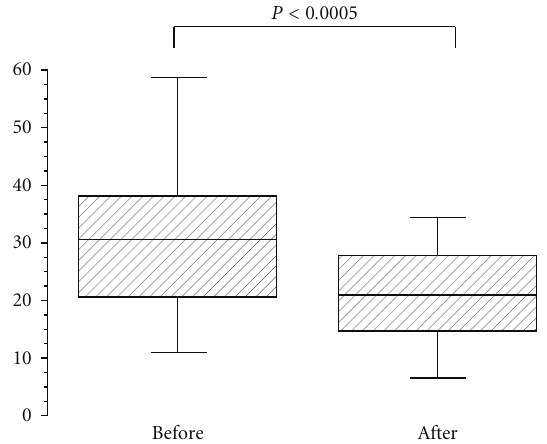
Figure 2: Leptin levels before and after weight loss . Leptin (ng/mL) was measured before and after weight loss as described in the methods. Box plots represent the 10th, 25th, 50th, 75th, and 90th percentiles. Statistical analysis was performed by Wilcoxon signed rank test.